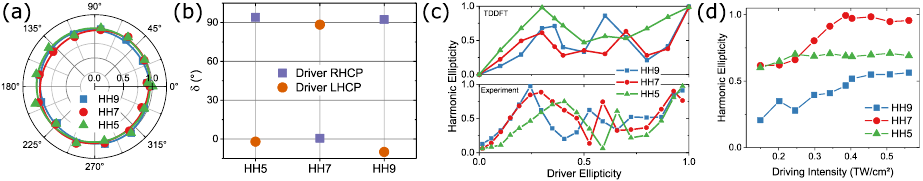
Figure 2: Circular high-harmonics from circularly and elliptically polarized driving pulses. (a) The transmitted harmonic intensity versus polarizer rotation for circular excitation. (b) Harmonic major axis after propagation through a tuneable quarter-wave plate, for the case of circular excitation. (c) Evolution of the harmonic ellipticities over driver ellipticity for major axis along (100)-direction. Upper panel TDDFT simulations, lower panel experimental results. (d) Harmonic ellipticities versus driving intensity for ε = 0.3 and θ = 15◦, indicating strong - field control of the harmonics’